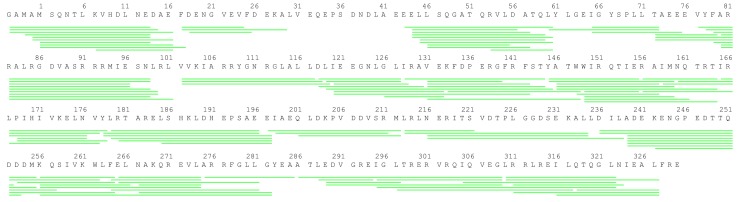
Peptide coverage of σS.The sequence coverage map for σs in the HDX-MS study. Green lines shown below the protein sequence represent the digested peptides identified and analyzed in this study.